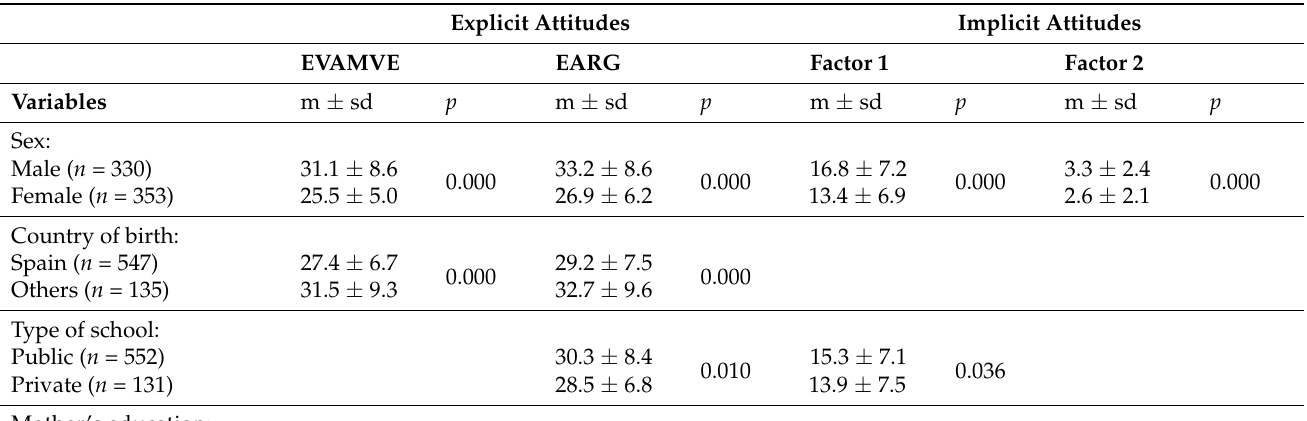
Table 3. Score of variables that measure sexist attitudes, according to the sociodemographic variables of the